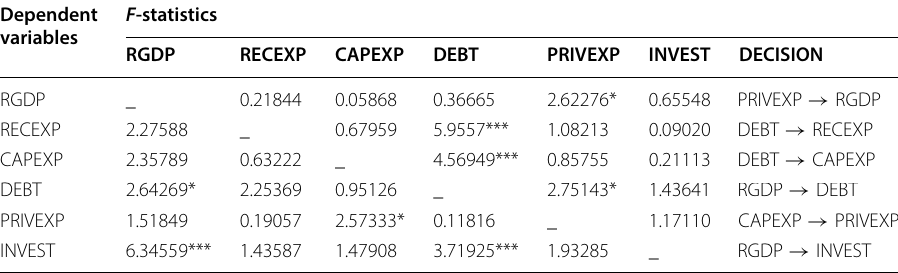
Table 5 Pairwise Granger Causality Tests